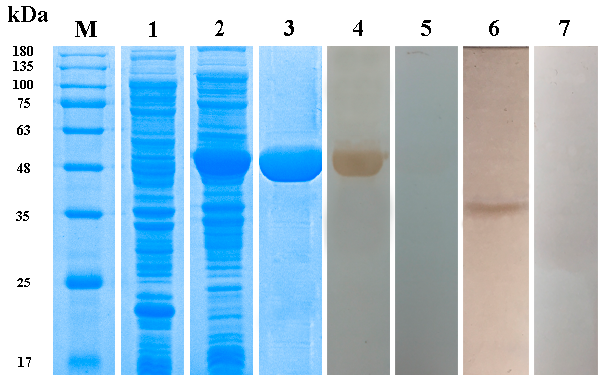
Figure 5. Purification and Western blotting of recombinant rTmAnxB3. M, Protein markers; 1, pET32a-vector; 2, pET32a-TmAnxB3; 3, Purified rTmAnxB3; 4, rTmAnxB3 detected by T. multiceps -positive goat serum; 5, rTmAnxB3 detected by T. multiceps -negative goat serum; 6: Western blot of T. multiceps extracts detected by rabbit anti-rTmAnxB3-IgG; 7, Western blot of T. multiceps extracts detected by healthy rabbit serum.